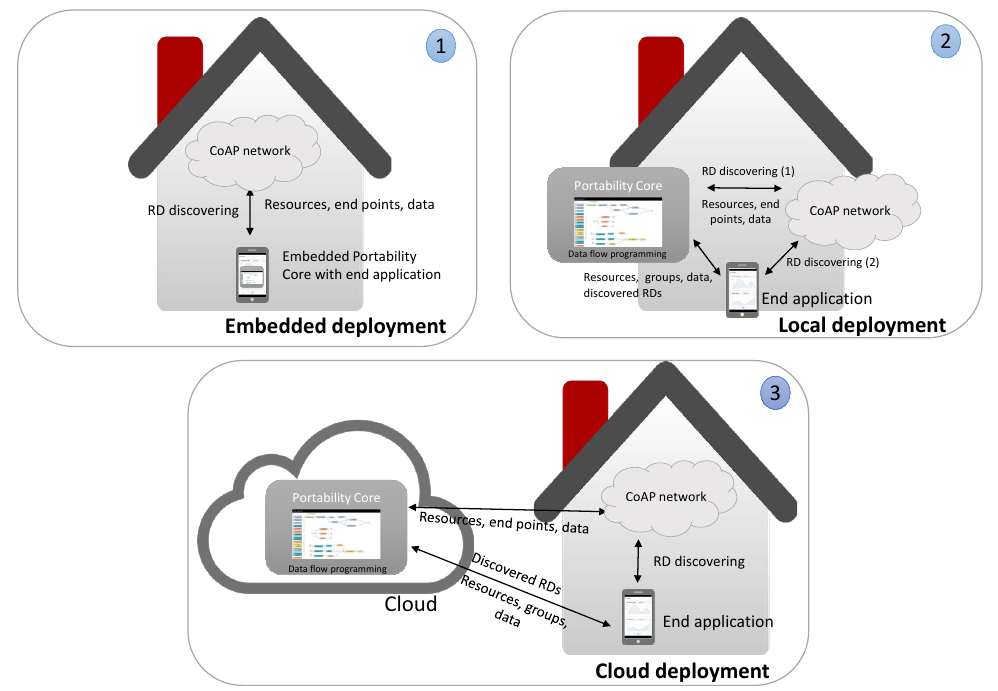
Figure 4. Possible deployment configurations in